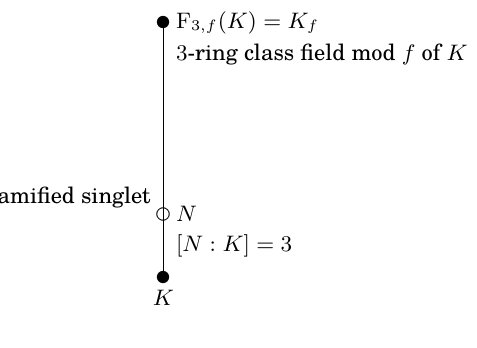
Figure 8: Ring class field modulo f = 63 = 3 2 · 7 over K .